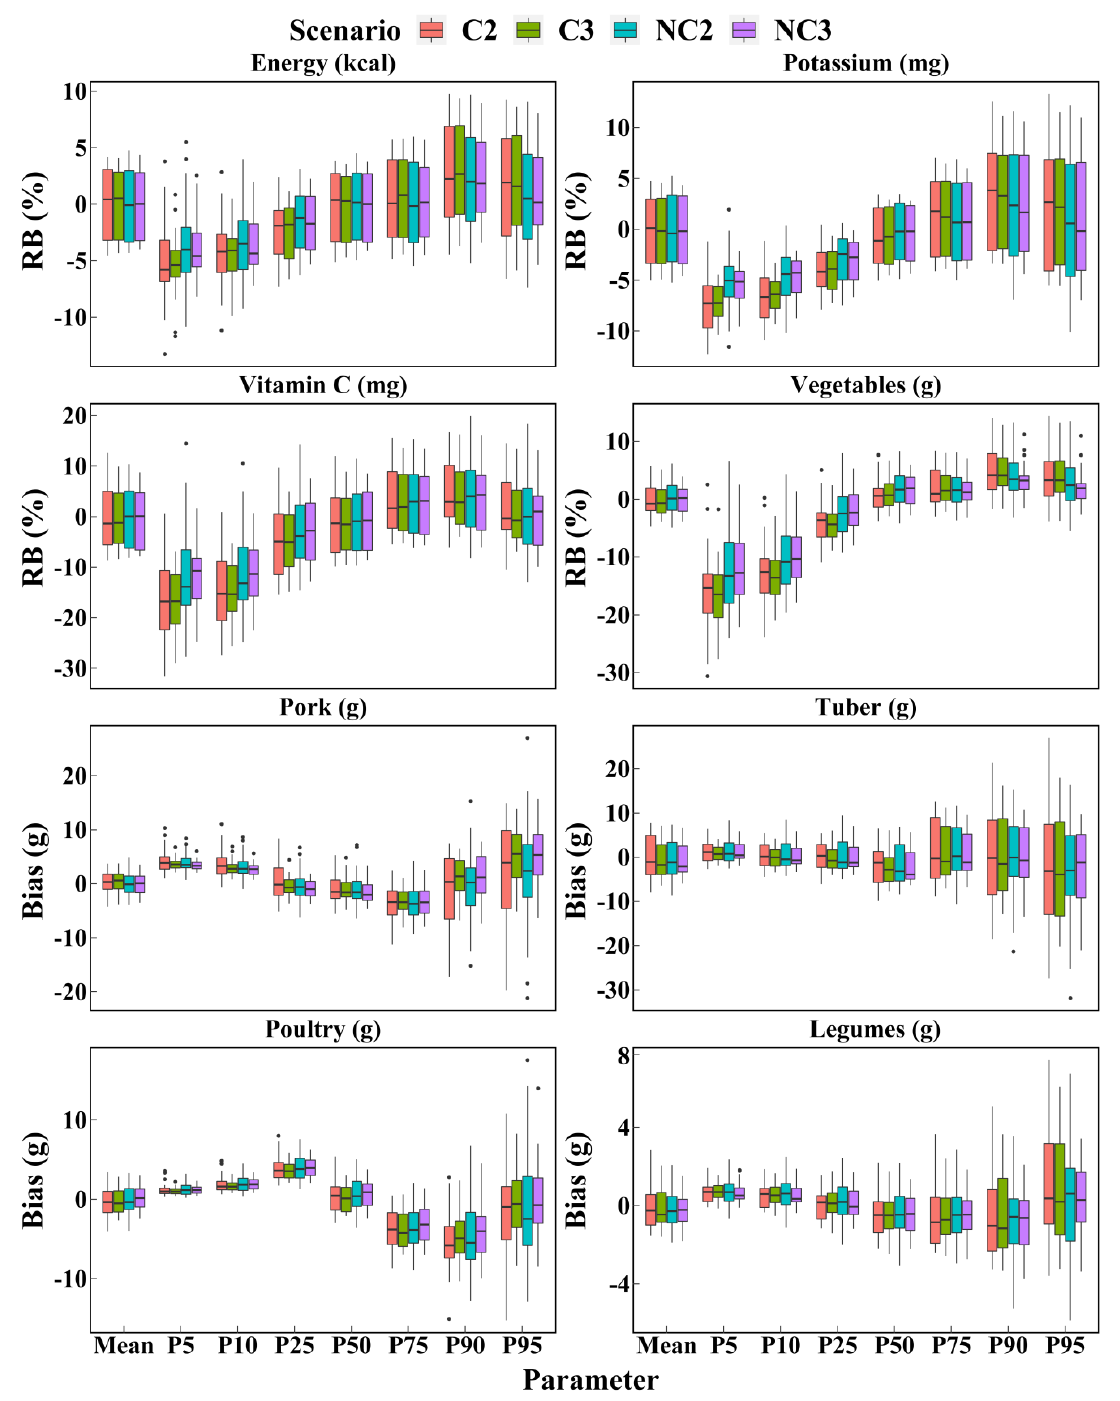
Figure 2. Boxplots of bias and relative bias of intake calculated for the four scenarios based on the NCI method. Boxplots of bias and relative bias for each dietary component calculated for the 4 sce- narios are available in Supplementary Figure S1. C2 = 2 consecutive days; C3 = 3 consecutive days; NC2 = 2 non-consecutive days; NC3 = 3 non-consecutive days; RB = Relative bias.